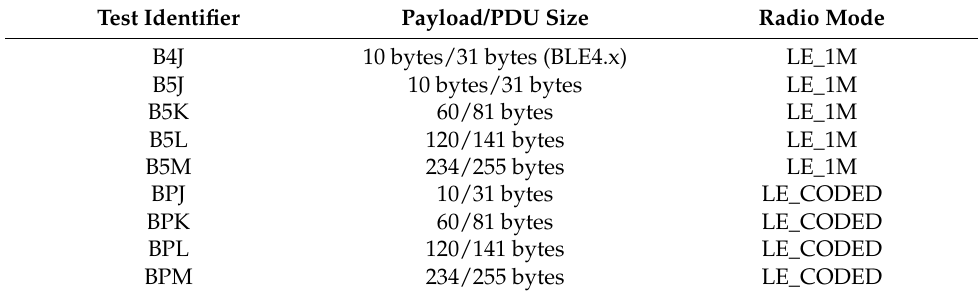
Table 3. Summary of test